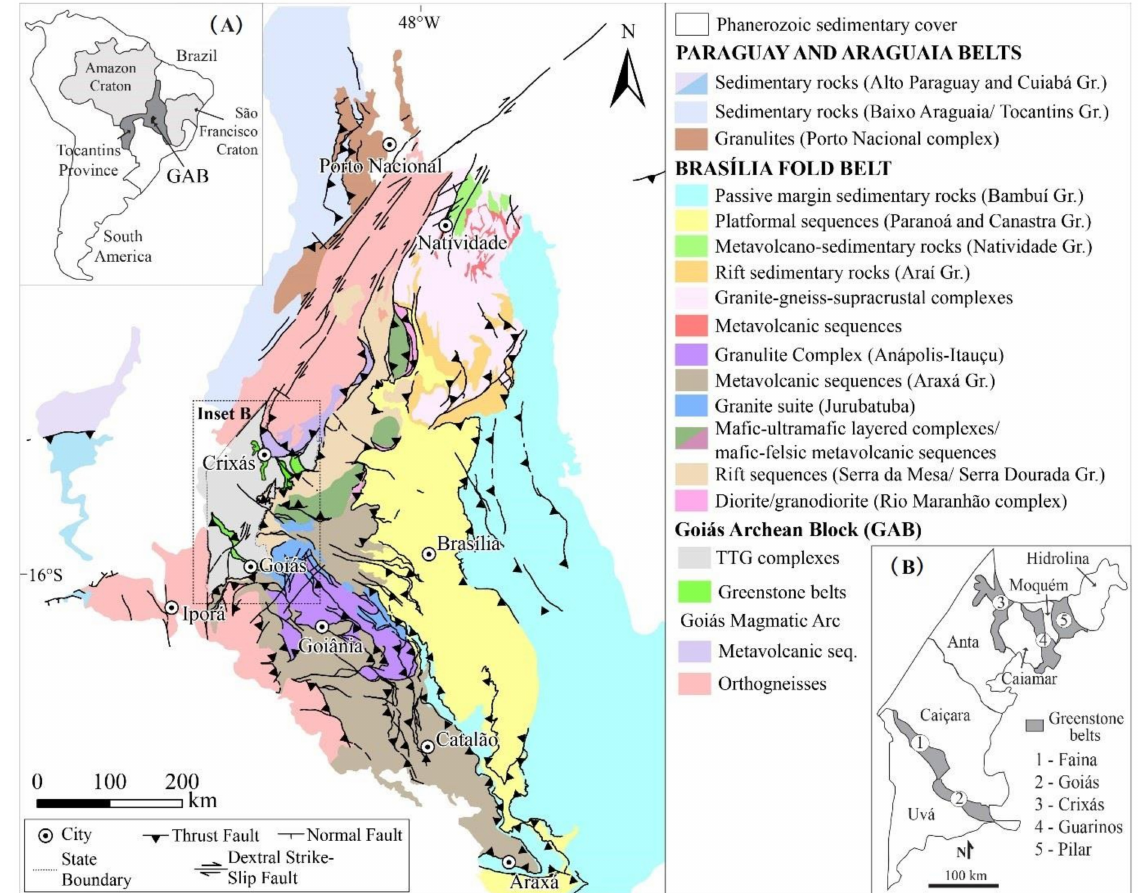
Figure 1. Geology of the Bras í lia fold belt (modified after Pimentel et al. [17]). ( A ): location of the GAB in South America; ( B ): greenstone belts and TTG terranes of the Goi á s Archean